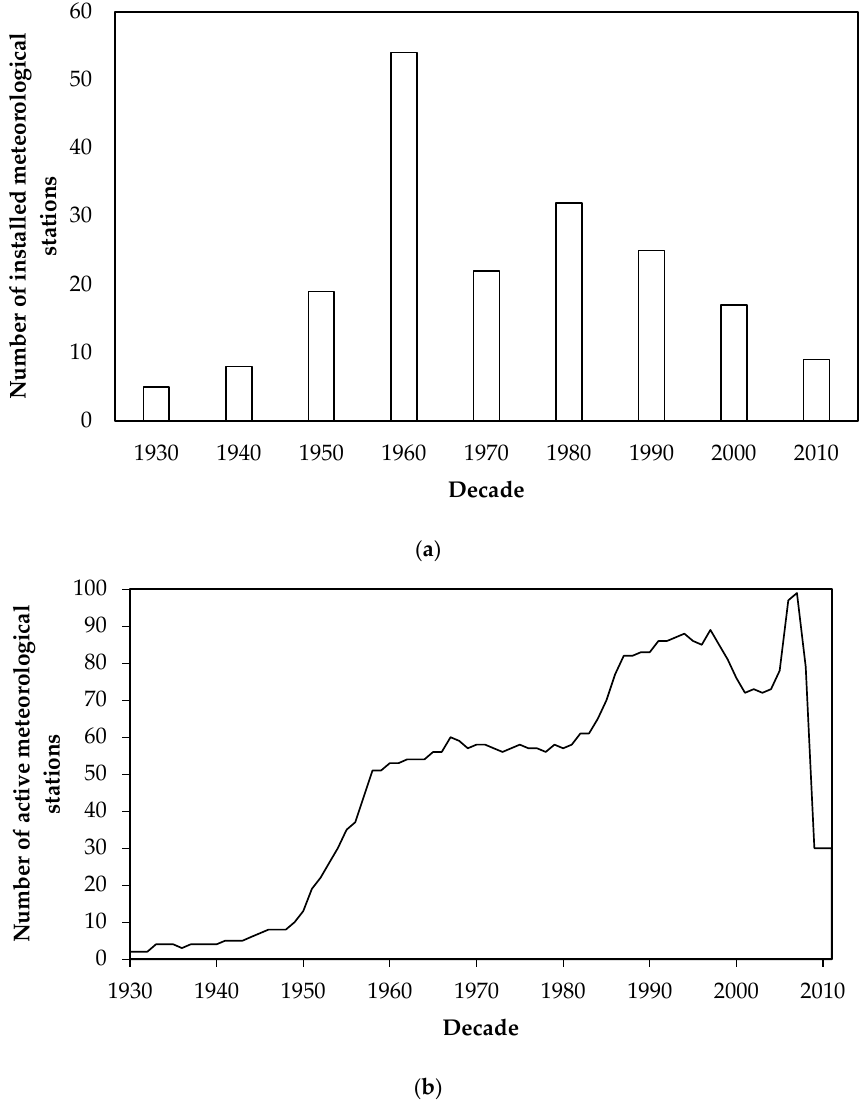
Figure 3. Meteorological stations installed by the regional autonomous corporation for the study area in Cundinamarca, Colombia. ( a ) Distributed by number installed per decade; ( b ) Distributed by active stations.